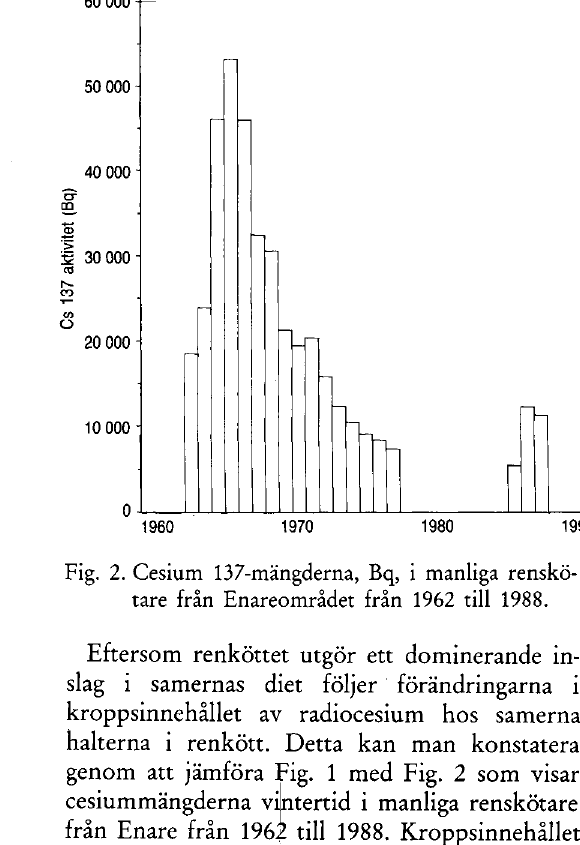
Fig. 2. Cesium 137-mängderna, Bq, i manliga renskö- tare från Enareområdet f rån 1962 till 1988.